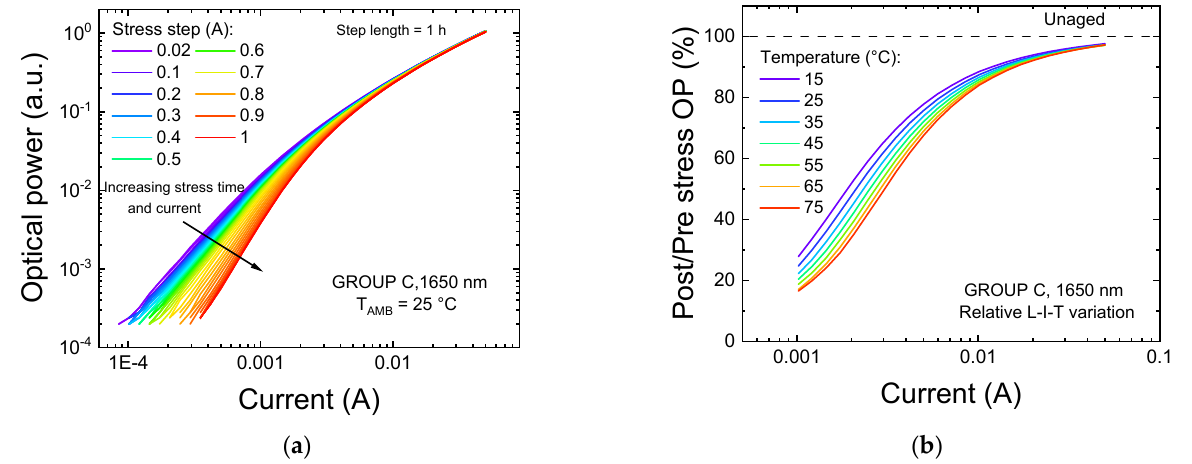
Figure 6. Variation of the optical characteristics of a group C sample during the step-stress procedure. ( a ) L–I characteristics measured after each stress cycle at T AMB = 25 °C. ( b ) Relative variation of the L–I–T characteristic after the entire step-stress procedure. The dashed line represents the reference level, corresponding the optical emission of the unaged device at each measuring